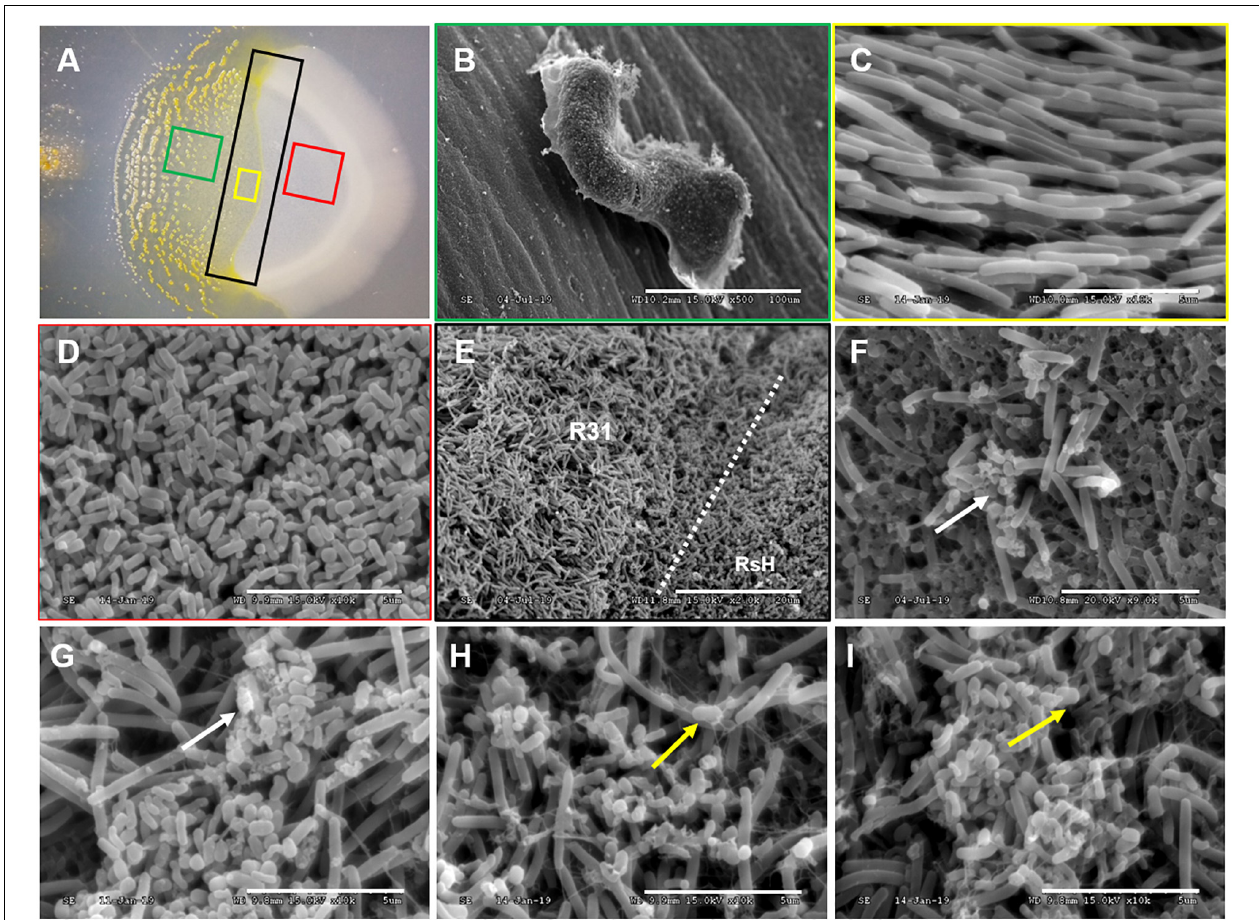
FIGURE 4 | SEM demonstrating the predation of RsH by strain R31. Taking a sample of the strain R31 predation on RsH in CFL plate (A) for scanning electron microscope (SEM) observation, (B) strain R31 that have completed predation in panel (A) green box formed a clear fruit body structure, scar bar = 100 µ m, (C) strain R31 preparing to predation in panel (A) yellow box showed tropism, scar bar = 5 µ m, (D) normal RsH cell was densely distributed with complete morphological structure, scar bar = 5 µ m, (E) the boundary line where strain R31 predation on RsH, strain R31, and RsH exist at the same time, and strain R31 swarmed in the direction of the RsH cells during predation, scar bar = 20 µ m, (F–I) strain R31 came into contact with RsH cells, the morphological structure of RsH cell is destroyed, and the cells were broken into small pieces. The white arrows indicated the R solanacearum cells whose cell structure has been destroyed. The yellow arrows indicated that strain R31 secretes a large amount of filamentous extracellular substance entangled RsH cells, scar bar = 5 µ